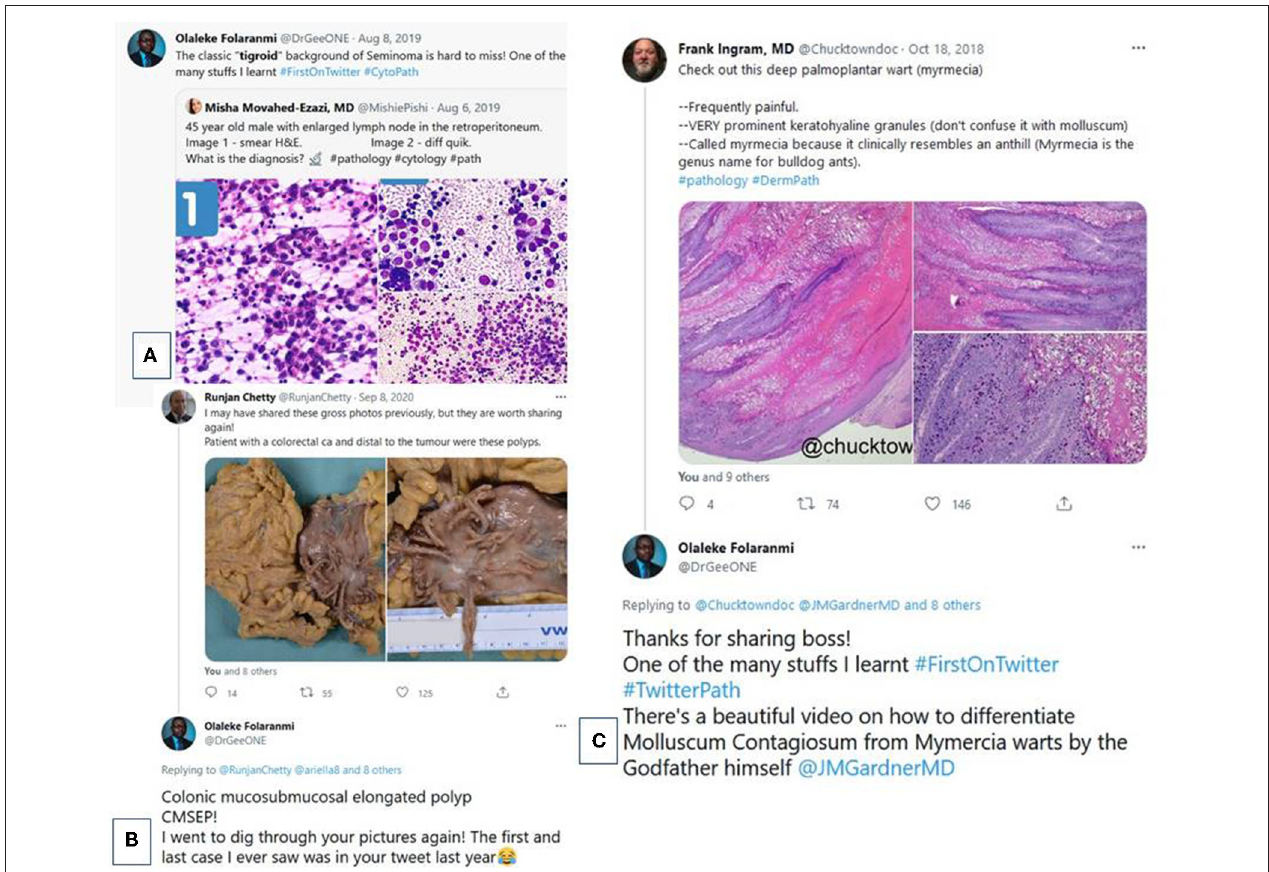
FIGURE 2 | Interactions with educative tweets. ( A) A quoted tweet from Misha Movahed-Ezazi, MD (@MishiePishi) by one of the authors amplifying one of the many valuable lessons in cytopathology that was learnt first on Twitter: the “tigroid” background of seminoma. ( B) A tweet by Frank Ingram, MD (@Chucktowndoc) highlighting the salient facts in distinguishing between Myrmecia warts and Molluscum based on morphology. ( C) A tweet by Runjan Chetty, FRCPC, FRCPath (@RunjanChetty) showcasing an extremely rare lesion ‘colonic mucosubmucosal elongated